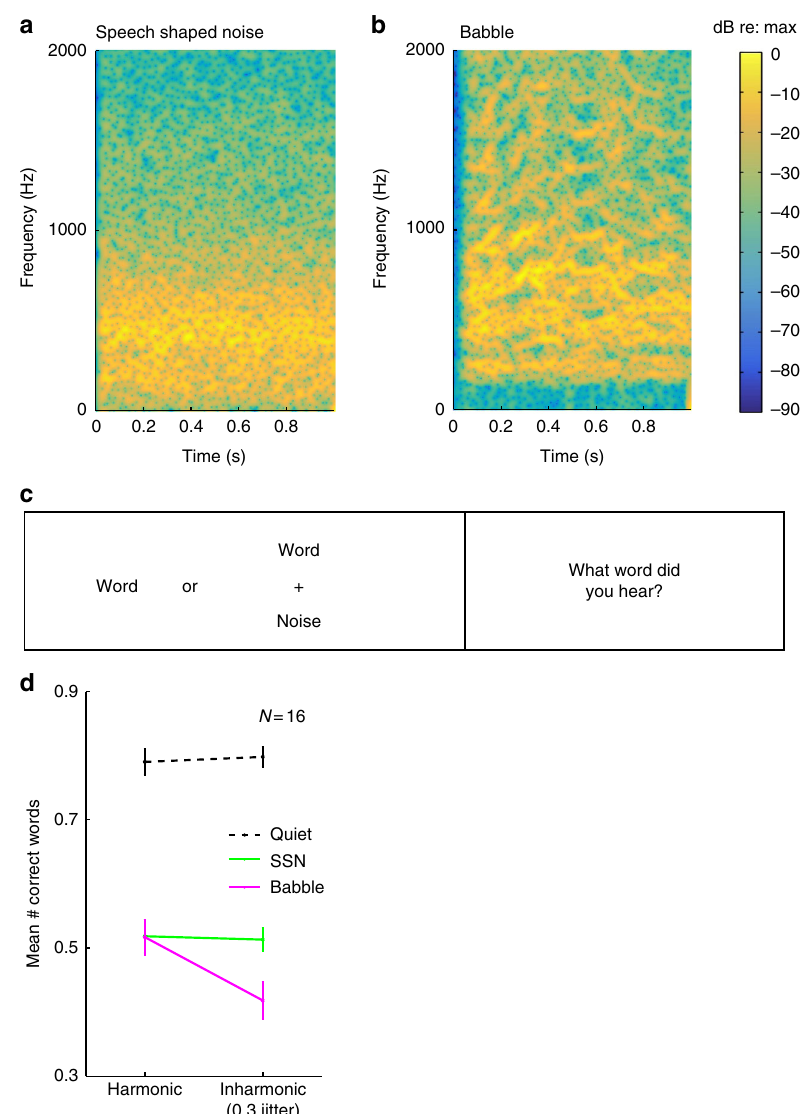
Fig. 4 Intelligibility of harmonic and inharmonic speech in speech-shaped noise and babble (Experiment 3). a Spectrogram of example of speech-shaped noise. b Spectrogram of example of babble (20 talkers). c Schematic of trial structure for word recognition task. d Word recognition in quiet, speech- shaped noise, and babble. Error bars denote